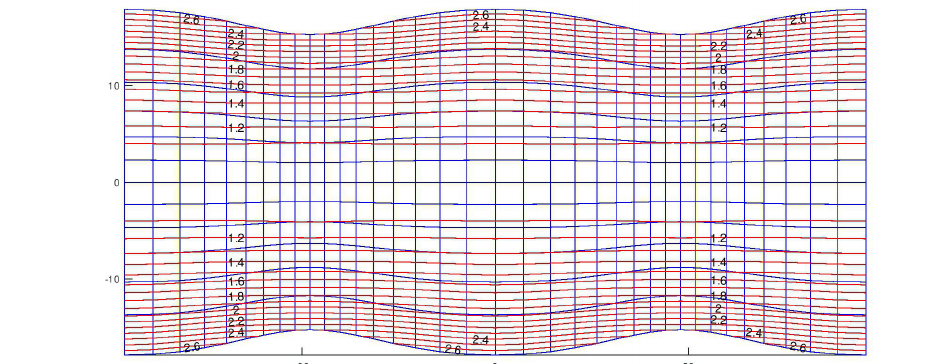
Fig. 8. The cartographic grid and the distribution of distortions obtained in the normal cylindrical projection created with the Bugayevskiy